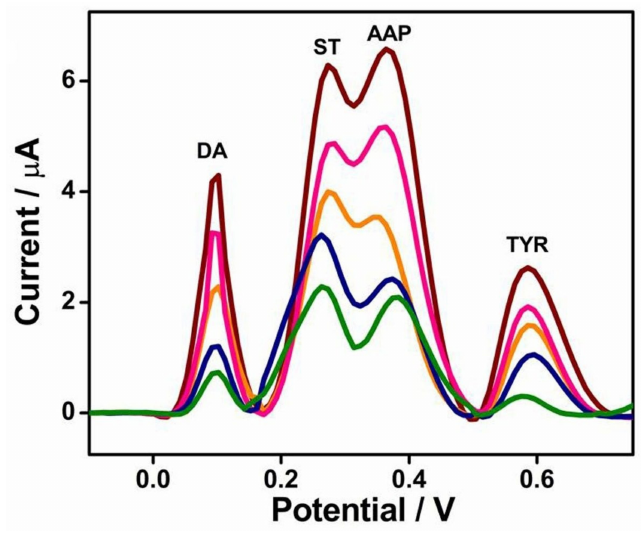
Figure 6. Interference measurement of LaNiO 3 /carbon paste electrode (CPE) sensor using diffential pulse voltammetry (DPV) technique in 0.1 M PBS of pH 7 containing varying concentrations of DA (from green to garnet curve 0.005 to 0.045 mM), serotonine (from green to garnet curve 0.03 to 0.17 mM), acetaminophen (from green to garnet curve 0.03 to 0.09 mM), and tyrosine (from green to garnet curve 0.0008 to 0.04 mM) [49]. Reproduced with the permission from Elsevier.